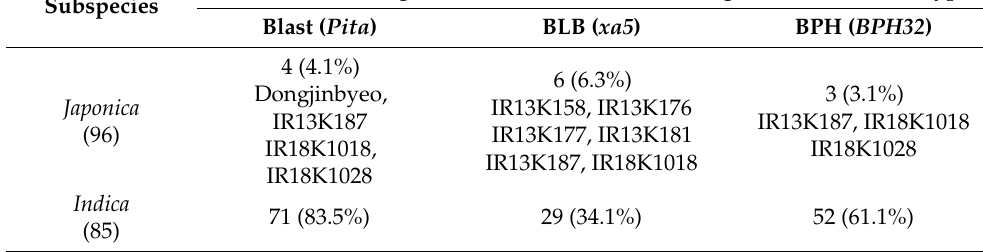
Table 7. Number (percentage) of japonica and indica rice accessions harboring the resistance alleles of Pita , xa5 , and BPH32 among 181 rice germplasm accessions.